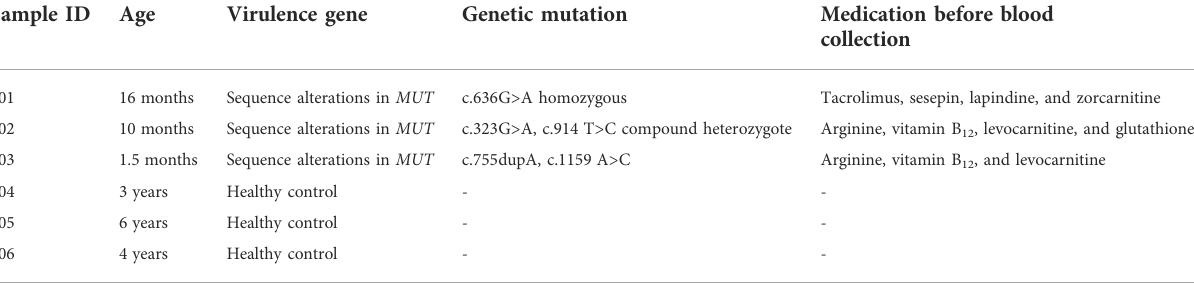
TABLE 1 List of MMA donors with their genotypes and clinical features used in this study.